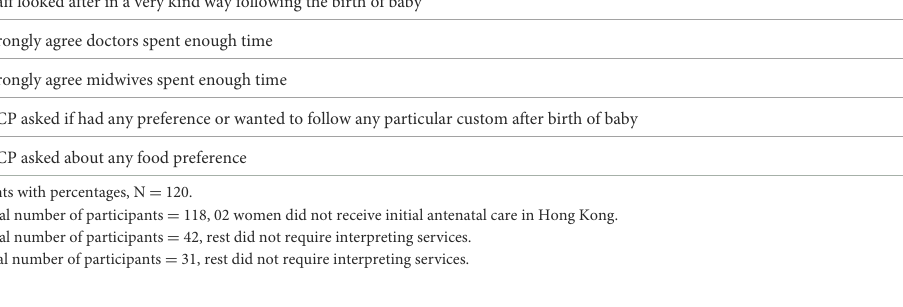
TABLE 4 Satisfaction with maternity care services (counts with percentages, N =